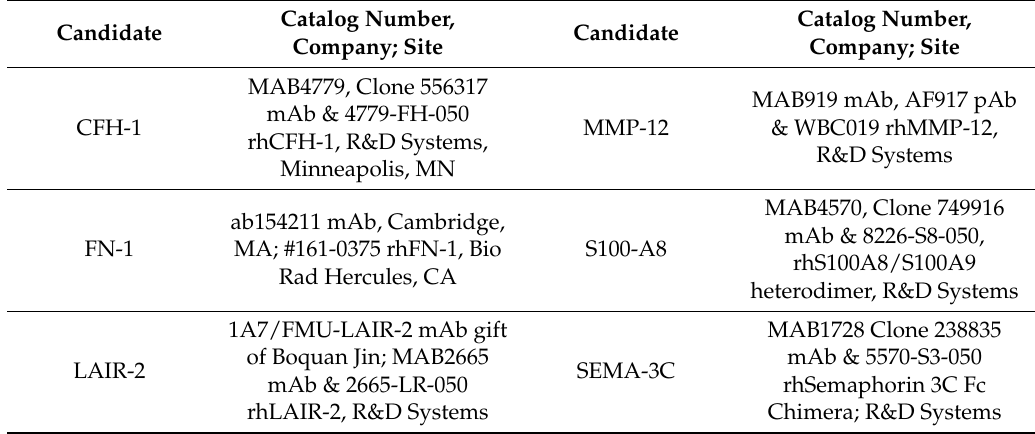
Table 7. Antibodies and recombinant proteins